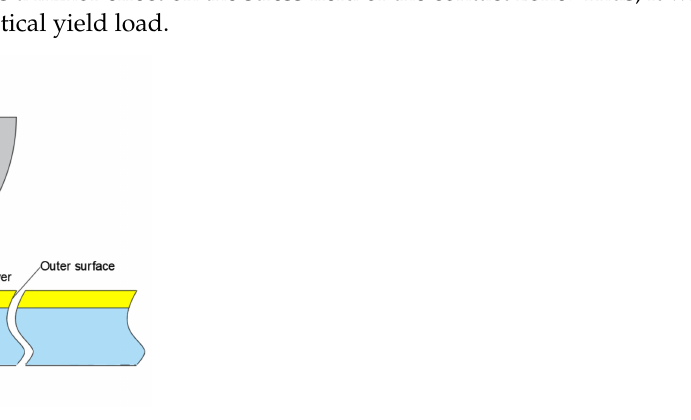
Figure A1. Separation of the computational model from external material.